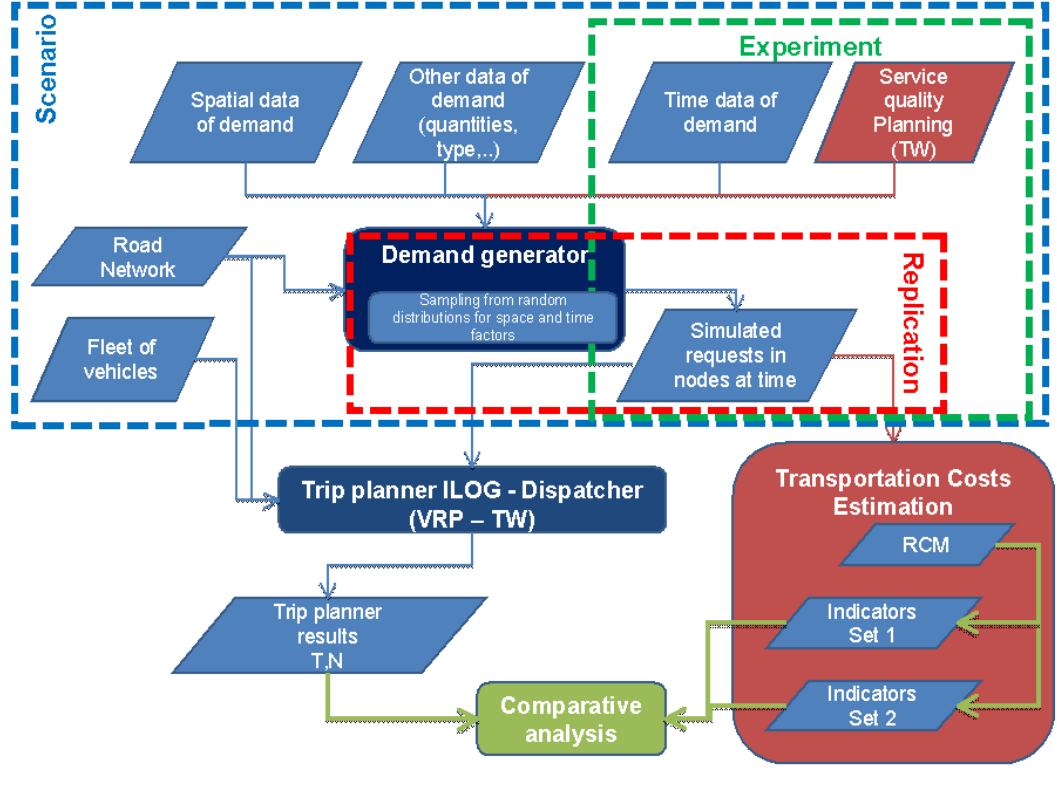
Figure 2. Chart of the comparative